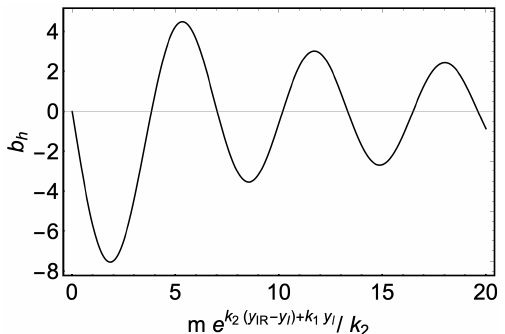
Figure 4 . The function b h defined in eq. (4.21) as a function of the normalized mass parameter m e k 2 ( y IR − y I )+ k 1 y I /k 2 . The KK graviton masses are determined via b h = 0 . Here, we take k 1 y I = 10 , k 2 y I = 20 , k 2 y IR = 40 as reference values. The first excitation mode is obtained around m ∼ 4 k 2 e − k 2 ( y IR − y I ) − k 1 y I